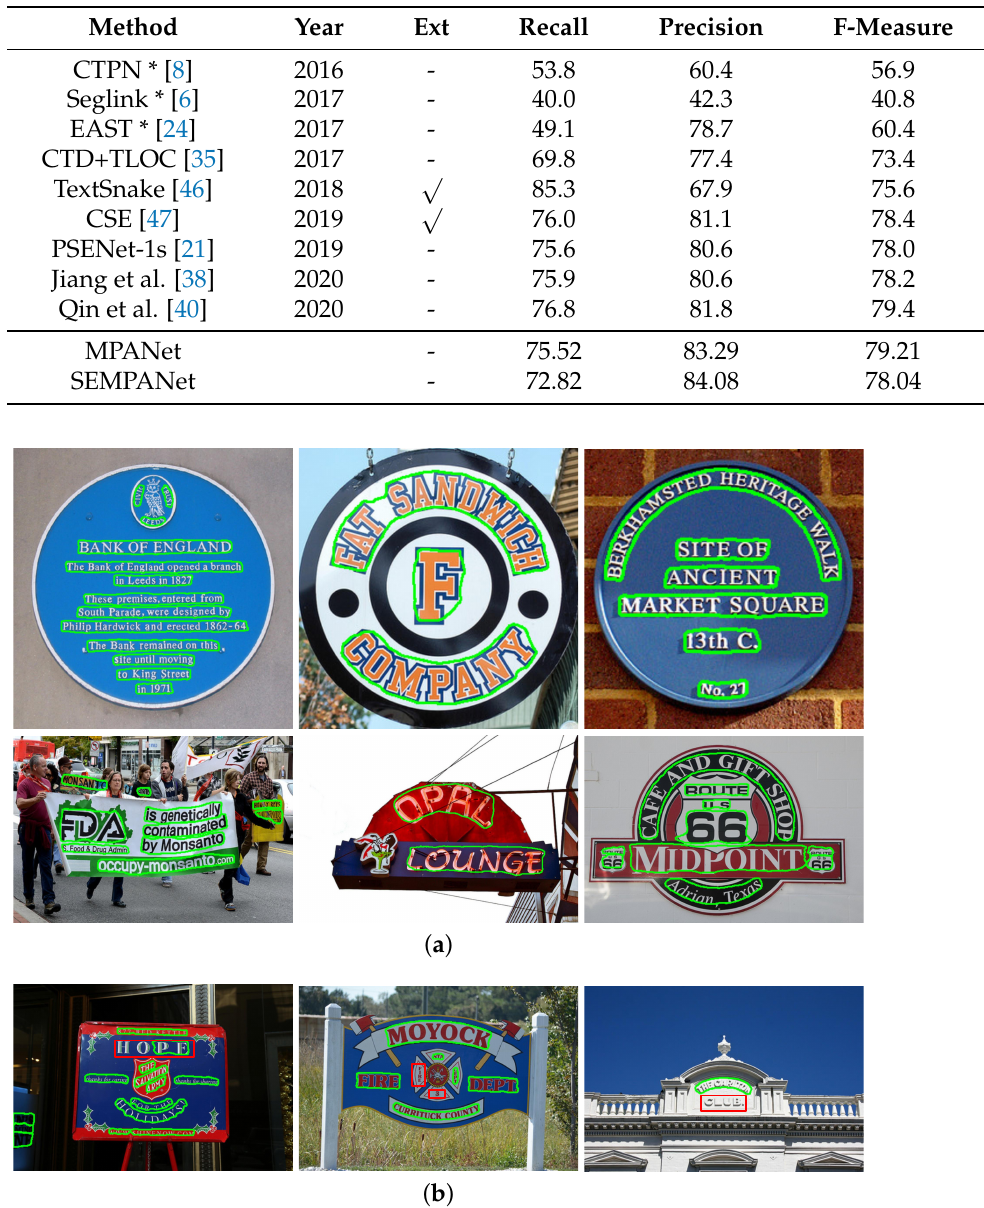
Figure 7. Some visualization results from CTW1500. The green boxes in ( a , b ) and the red boxes in ( a ) represent the evaluation results of the text and the error detection boxes of them